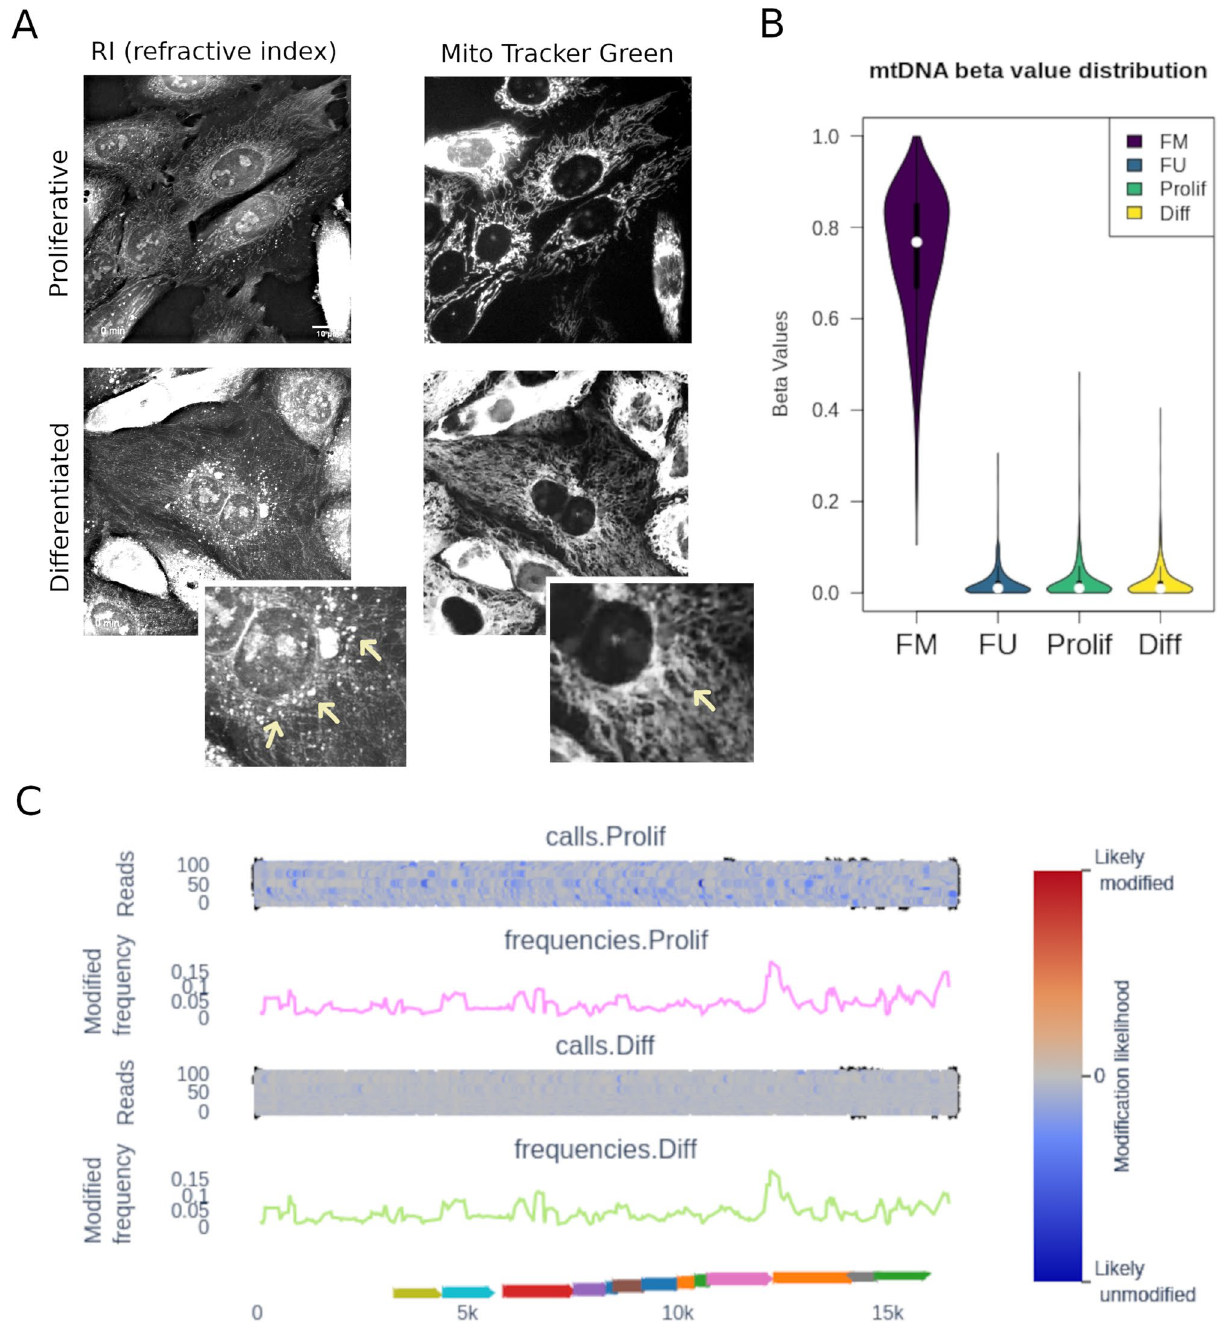
Figure 3. Methylation of mitochondrial DNA measured by nanopore sequencing of a liver progenitor cell line. ( A ) Holotomography images of proliferative (progenitor) HepaRG cells and their differentiated progeny. Left panel: Refractive Index (RI) map. Right panel: MitoTracker Green staining to distinguish mitochondrial content and distribution. Insets with higher magnification are shown for differentiated HepaRG, with arrows indicating lipidic droplets and denser mitochondrial network in RI and Mito Tracker Green, respectively. ( B ) mtDNA enriched DNA extracts from HepaRG cells were linearized and sequenced, as described in Fig. 2A. The distribution of 5mCpG beta values (proportion of methylated calls relative to the total calls for a given site) in both strands combined is shown for proliferative (Prolif) and differentiated (Diff) HepaRG, as well as FM and FU controls. ( C ) Methylation frequency and likelihood (pile-plots for the first 100 reads) is shown for proliferative and differentiated HepaRG (one representative sample of three independent differentiation assays). Methylation likelihood scale shown in the pile-plots represents unlikely methylated in blue, likely methylated in red, and intermediate values in gray. Gene mapping to mtDNA are shown in the bottom track as colored